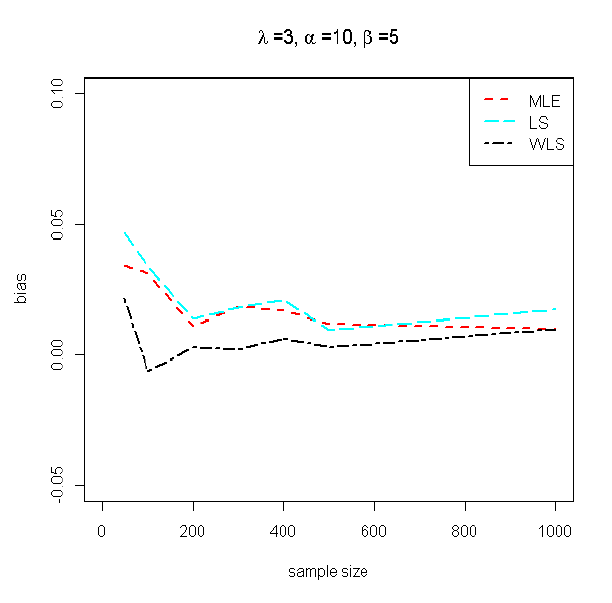
Figure 3. Bias of estimator ˆ λ versus sample size n for different